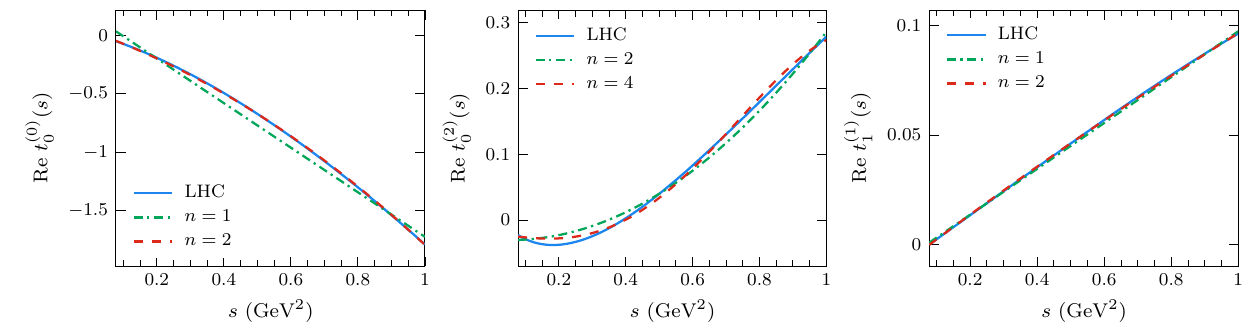
Fig. 5 Comparison of the LHC integral (blue solid line) shown in Fig. 4 with order n polynomials (red dashed and green dash-dotted lines) with coefficients fitted to reproduce the LHC